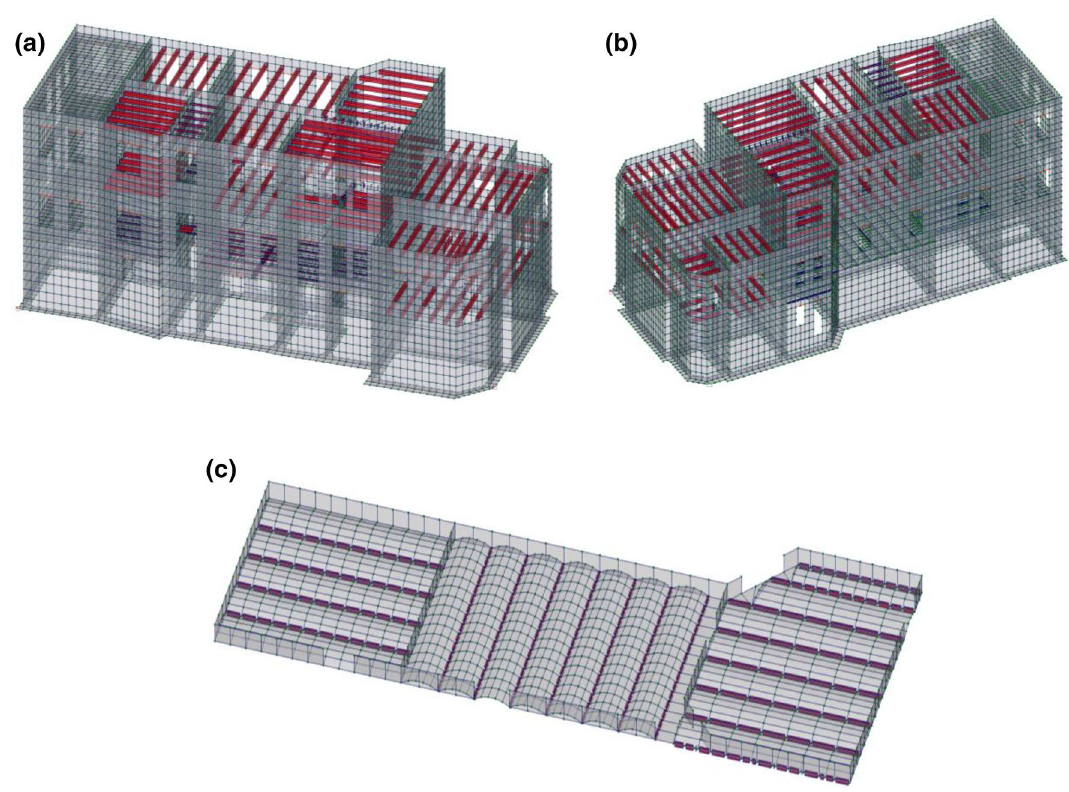
Figure 3. Design scheme of the building: ( a ) view from the main facade; ( b ) view from the side of the courtyard facade; ( c ) brick